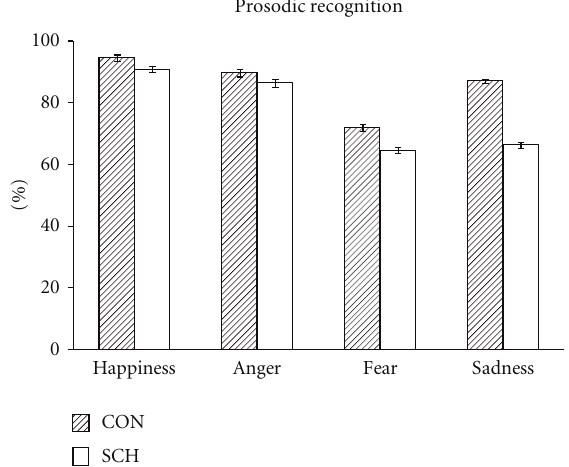
Figure 3: Means and standard errors for the percentage of correct responses in the prosodic emotional recognition task for males and females from the control (CON) and schizophrenic groups